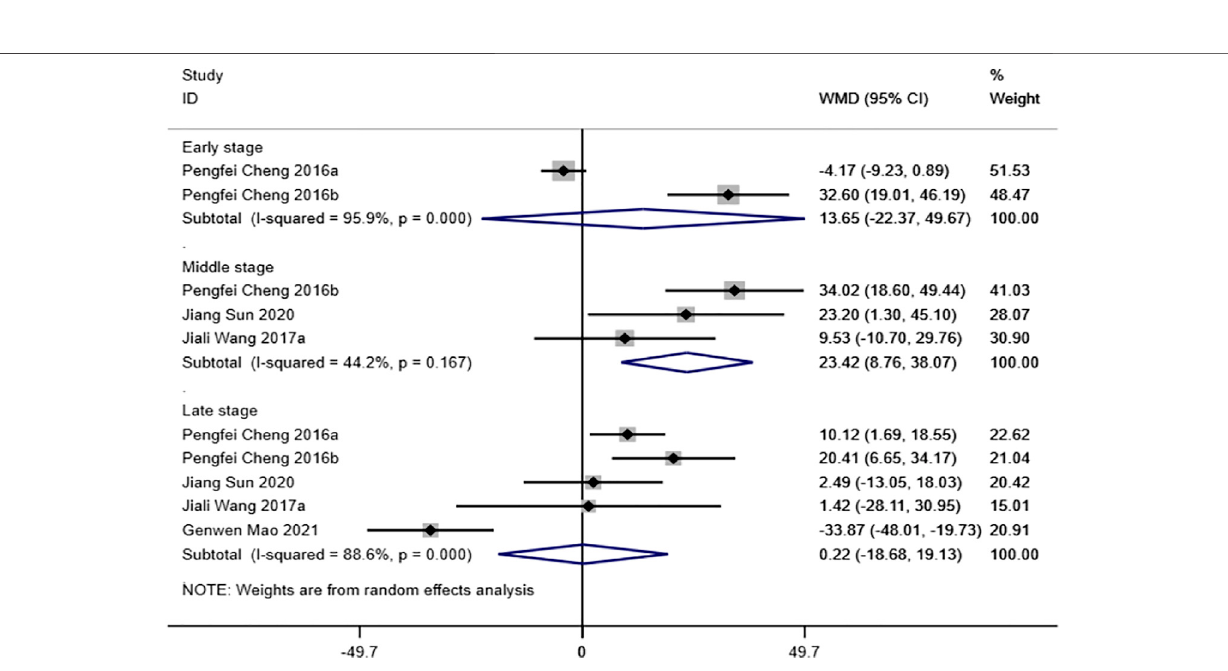
Frontiers in Bioengineering and Biotechnology |